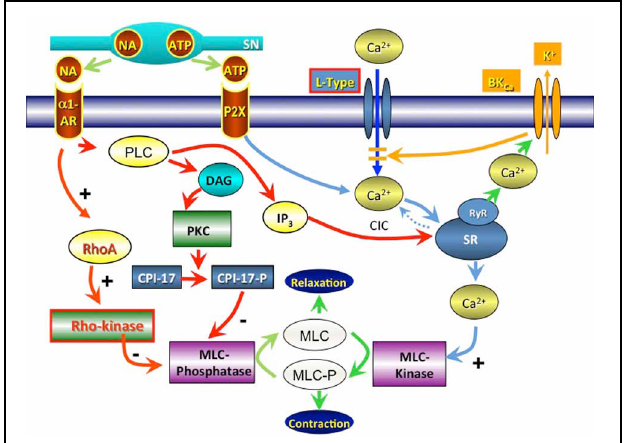
FIGURE 2 | Signal pathways involved in contractile activation of the vas deferens via noradrenaline (NA; α 1 -Adrenoceptors) and adenosine triphosphate (ATP; P2X receptors). SN, sympathetic neuron; PLC, phospholipase C; DAG, diacylglycerol; PKC, protein kinase C; RhoA, ras homolog gene family, member A; CPI-17, protein phosphatase 1 regulatory subunit 14A; MLC, myosin light chain; IP3, inositol trisphosphate; SR, sarcoplasmic reticulum; CIC, calcium-induced calcium release; RyR, ryanodine receptor; BKCa, big K + activated Ca 2 + channel; L-type, L-type voltage dependent Ca 2 +